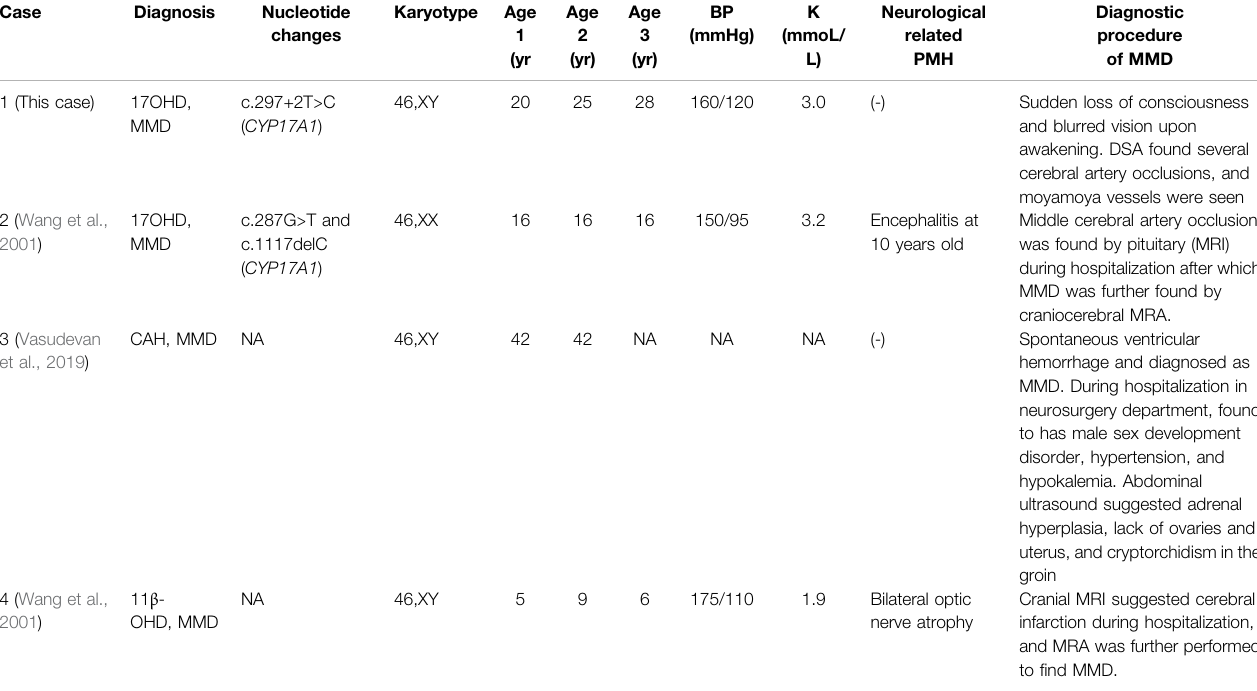
TABLE 3 | Previously reported cases of 17OHD or CAH with